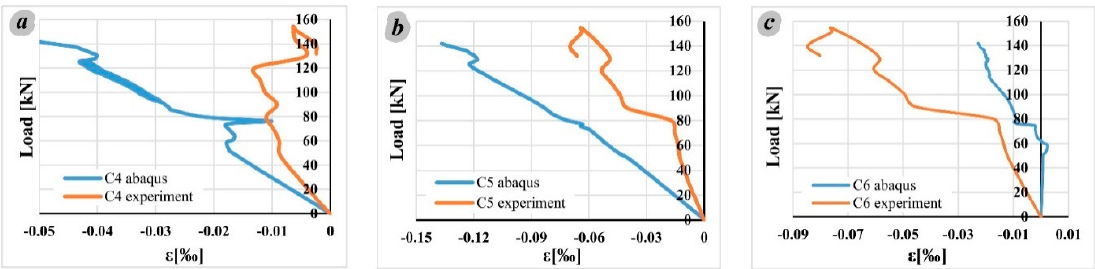
Figure 26. Experimental and numerical (model FEM B) strains of member W2 in gauges: ( a ) C4, ( b ) C5, and ( c ) C6.